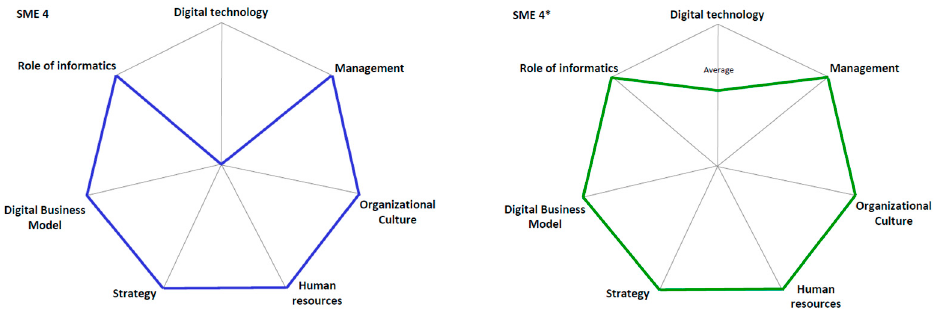
Figure 7. Polar chart for “what-if” analysis of SME 4 and SME 4*.